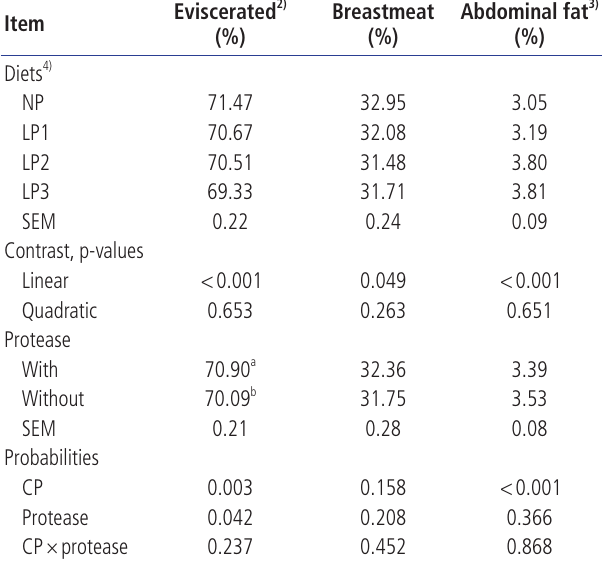
Table 3. Effect of crude protein level and protease enzyme supplementation on serum biochemical profile in broiler chickens at 35 days of age 1)